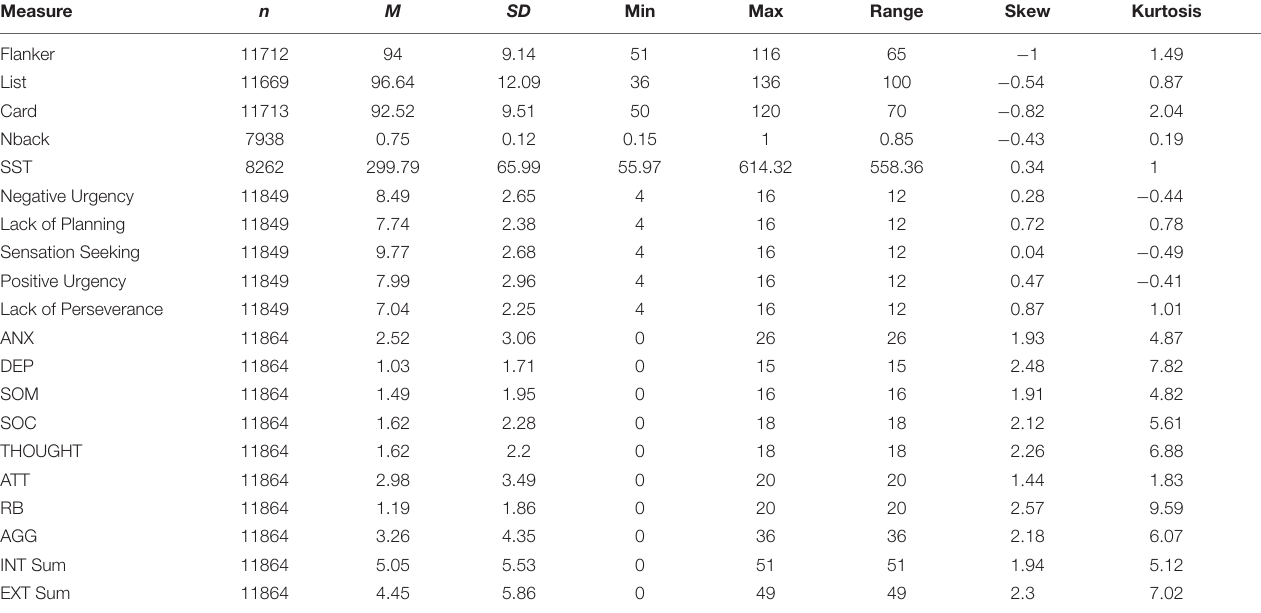
TABLE 1 | Descriptive statistics for cognitive tasks and survey